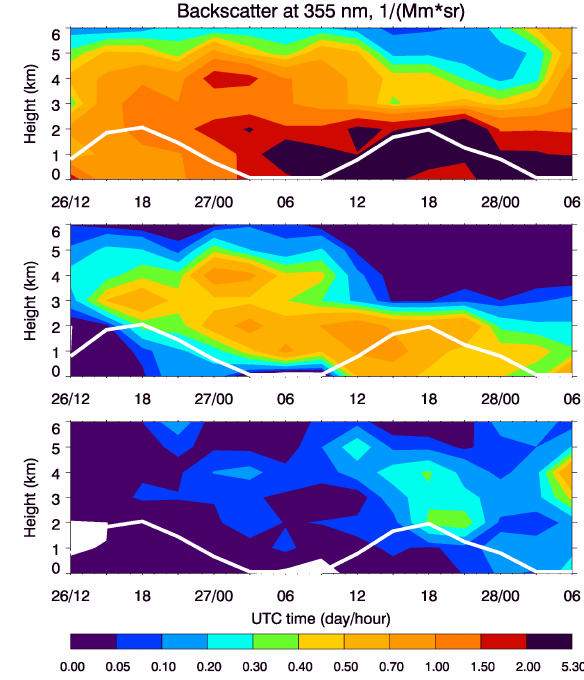
Figure 4. (a) Aerosol backscatter ((Mmsr) − 1 ) at 355nm simulated by the GEOS-5 GOCART model over GSFC from 00:00UTC on 26 August to 06:00UTC on 28 August 2013. ( b and c ) Similar to (a) but for biomass burning aerosol tagged to the Wyoming/Idaho (10– 118 ◦ W, 42–48 ◦ N) and Yosemite (115–124 ◦ W, 36–42 ◦ N) fires, re- spectively. White lines represent planetary boundary